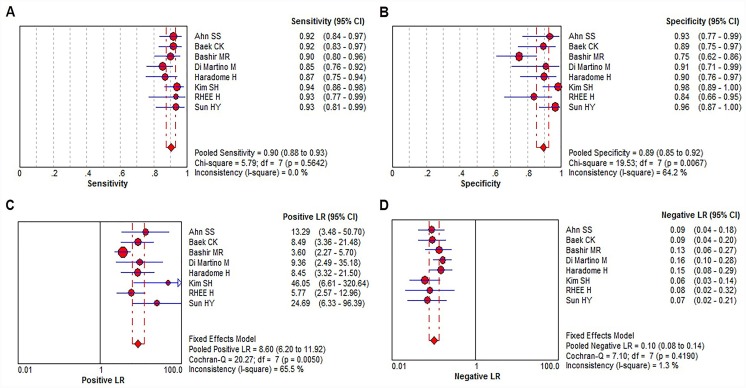
Forest plots of the estimates for Gd-EOB-DTPA-enhanced MRI in HCC diagnosis.(A) sensitivity analysis. (B) specificity analysis. (C) positive likelihood ratio analysis. (D) negative likelihood ratio analysis.